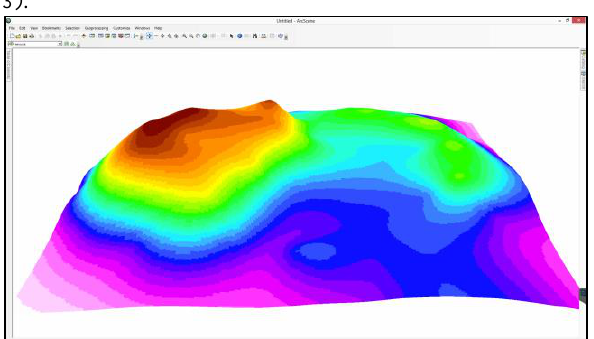
Figure 3. Digital surface model from GNSS points (Revúca)